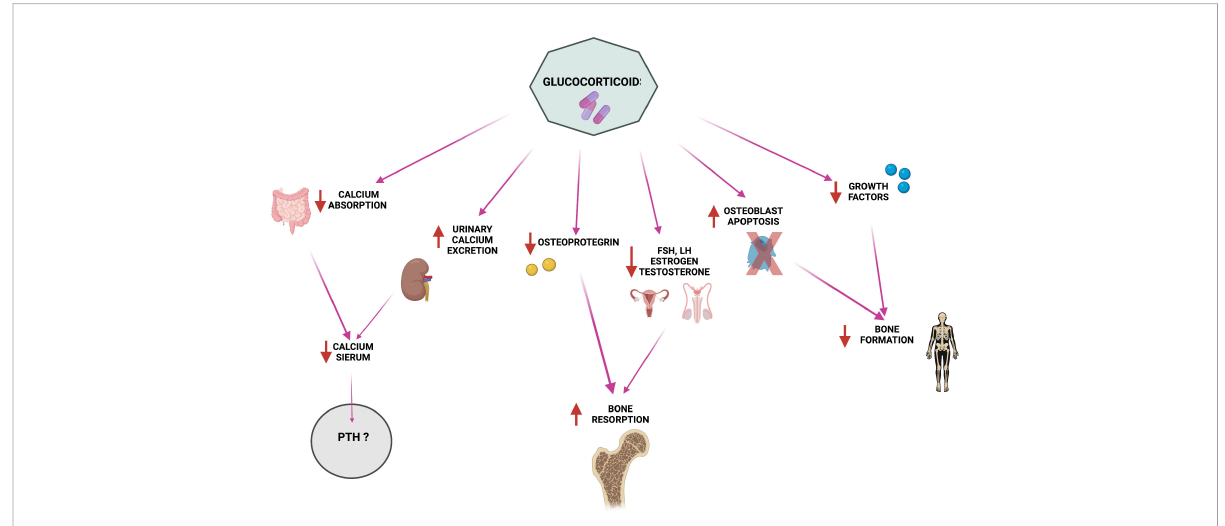
FIGURE 1 Pathophysiology of glucocorticoid-induced alterations in calcium homeostasis and bone metabolism. Created by